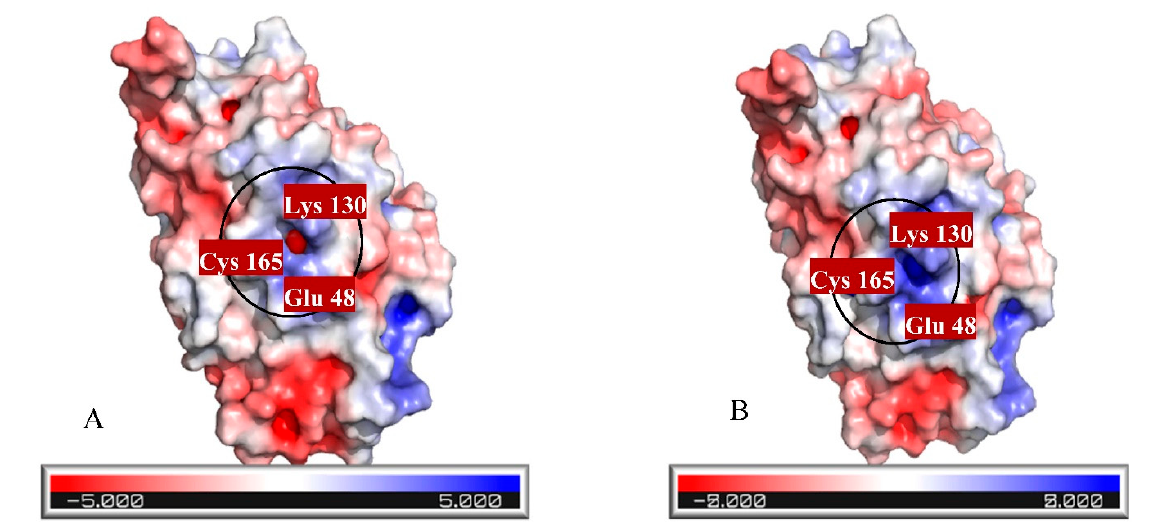
Figure 7. Electrostatic potential molecular surface of ( A ) wild-type and ( B ) mutant proteins. Table 6. The most important residues, pKa, of wild-type and mutant